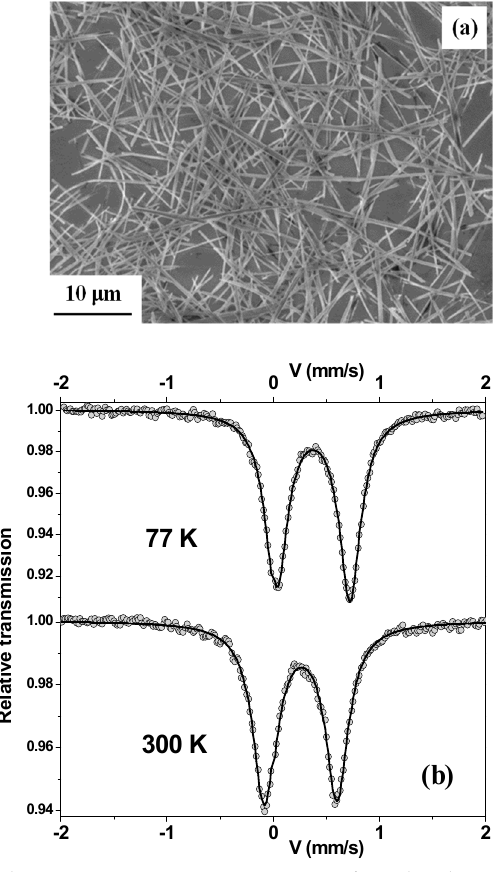
Figure 1. ( a ) Scanning electron microscopy (SEM) image of Fe-glycolate wires. ( b ) Mössbauer spectra at 77 and 300 K (recorded using magic-angle configuration).